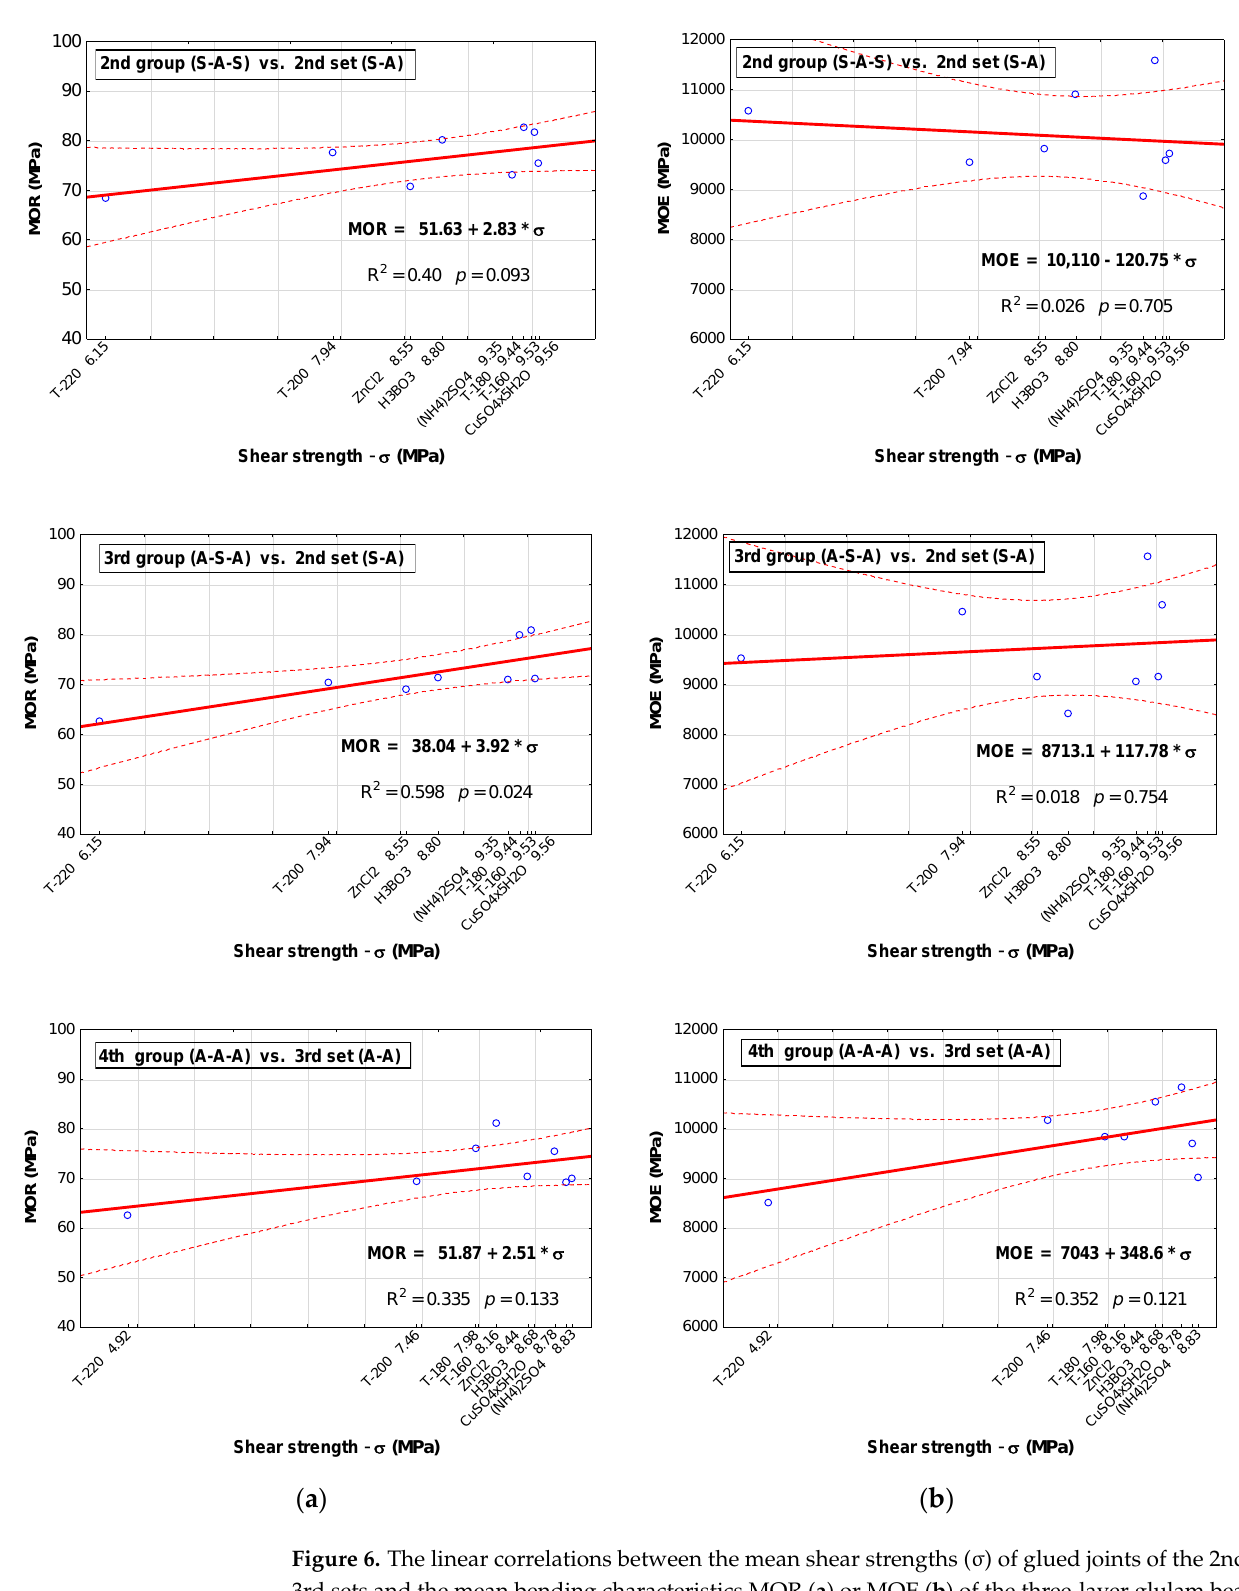
Figure 6. The linear correlations between the mean shear strengths (σ) of glued joints of the 2nd or 3rd sets and the mean bending characteristics MOR ( a ) or MOE ( b ) of the three-layer glulam beams of the 2nd, 3rd and 4th groups.